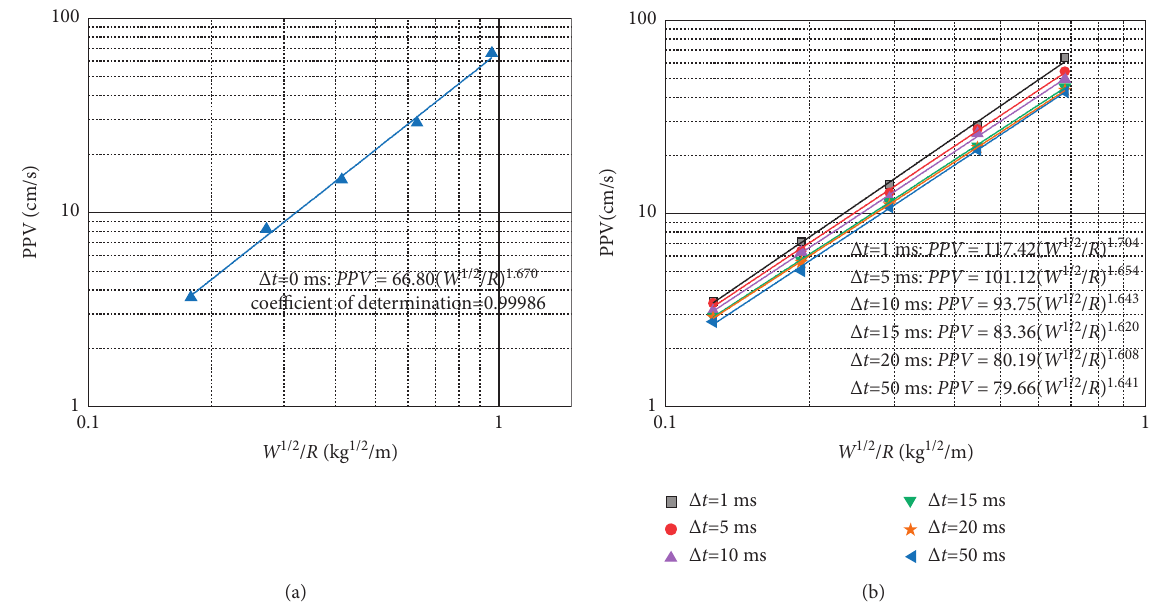
Figure 15: Blasting vibration attenuation law with different delay times. (a) Δ ( t ) � 0. (b) Δ (t) ≠ 0.